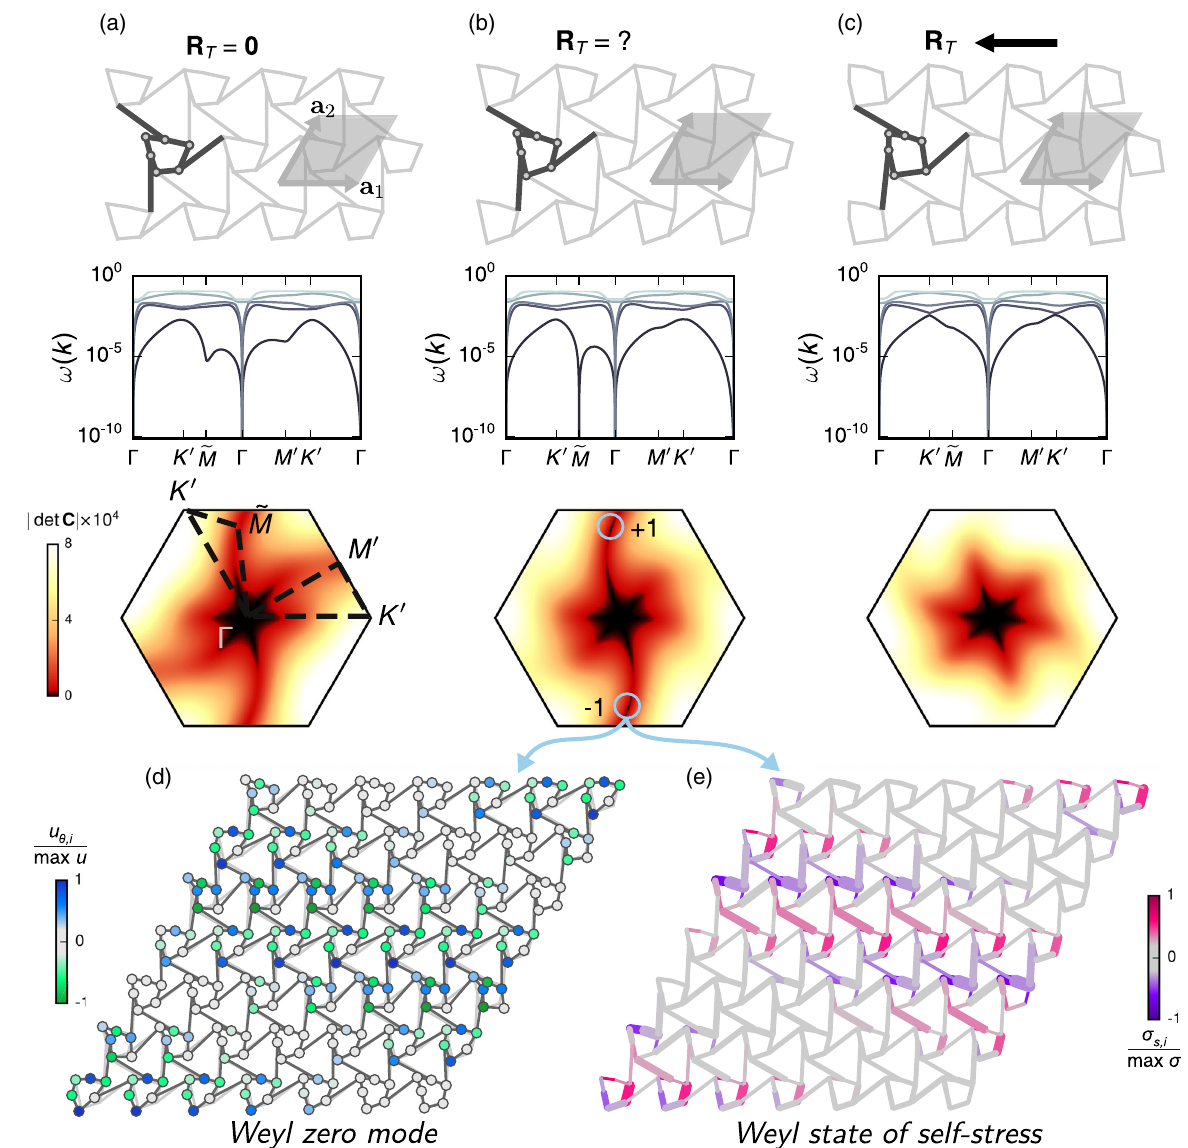
FIG. 3. Topological hexachiral lattices. (a) – (c) Three members of a single-parameter family of hexachiral gear lattices. The symmetric unit cell comprises six nodes (gray dots) and nine unique links (thick black lines). Below each lattice are shown the determinant of the Fourier-transformed tension-shear compatibility matrix in the BZ (intensity plot) and the lowest six eigenvalues along specific contours (line plots). The lattices (a) and (c) have a gapped spectrum everywhere except at k ¼ 0 . The topological polarization, calculated as described in the text, is 0 in (a) and − a 1 in (c). Lattices (a) and (c) are separated by a family of lattices with a pair of Weyl points at which a zero eigenstate exists. One such lattice is shown in (b) with the Weyl points at k ¼ (cid:2)ð − 0 . 295 =a; 3 . 001 =a Þ encircled. The winding numbers n w ¼ (cid:2) 1 are indicated. (d),(e) Visualization of the Weyl zero mode (d) and state of self-stress (e) at the lower Weyl point. ~ M The periodic variation of the modes is a consequence of the finite wave vector of the point at which the gap